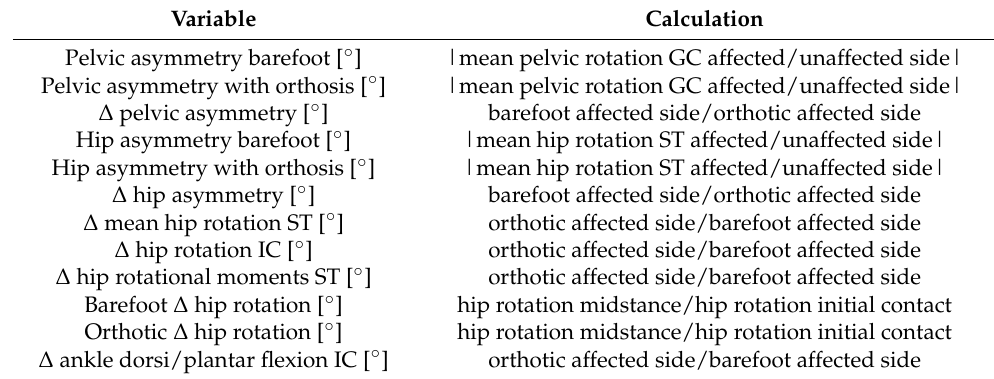
Table 1. Description of the calculation of the used variables. Variable